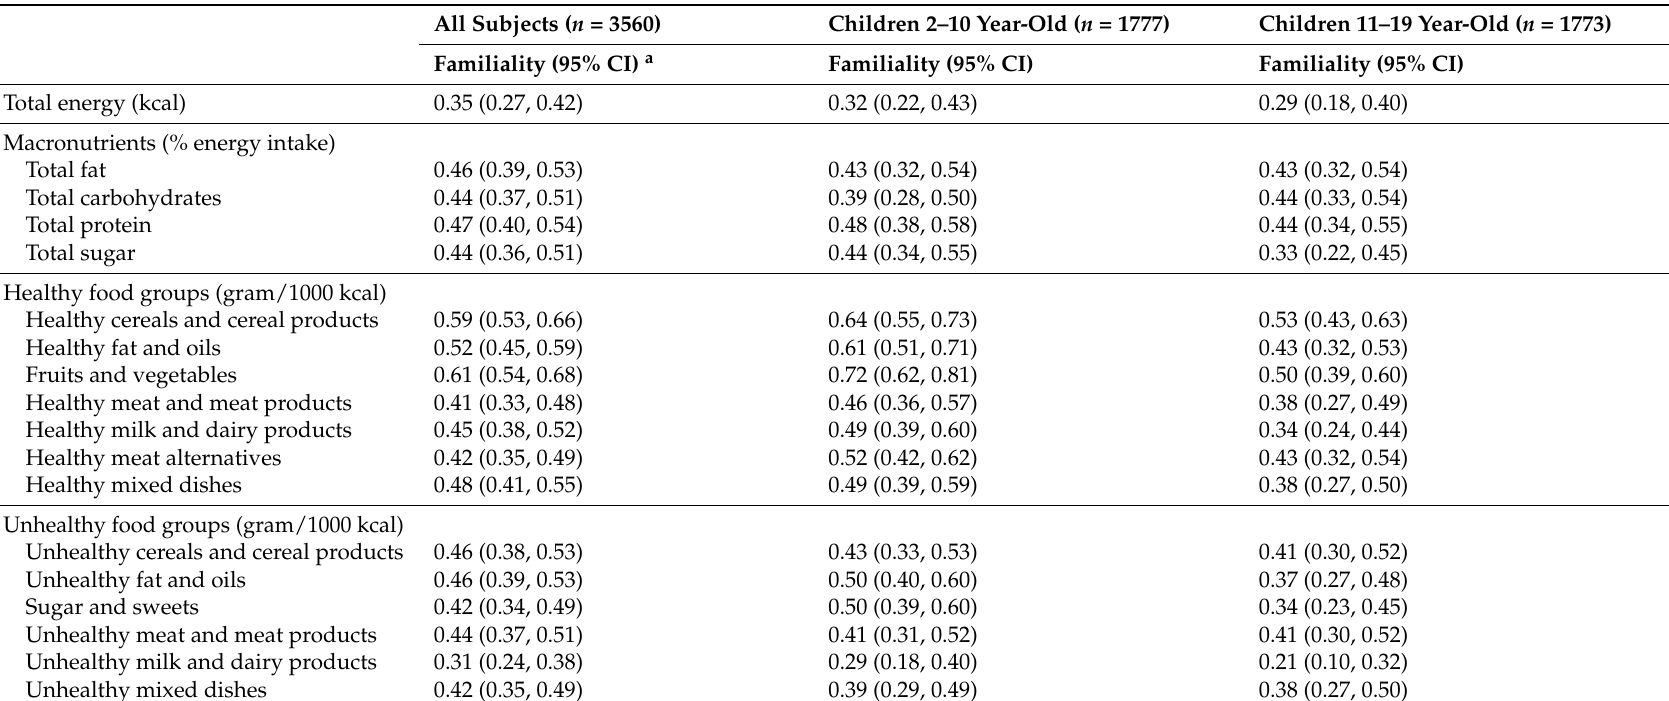
Table 5. Familiality estimates for all subjects and for younger and older